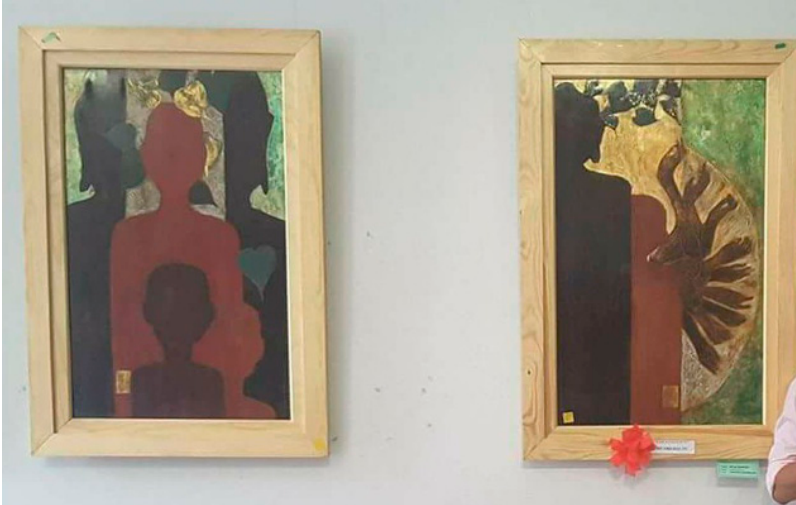
Figure 2. An Lac —Nguyen Truong An painted in 2017. The image was sourced from Tuoi Tre Newspaper (Diep 2017a).